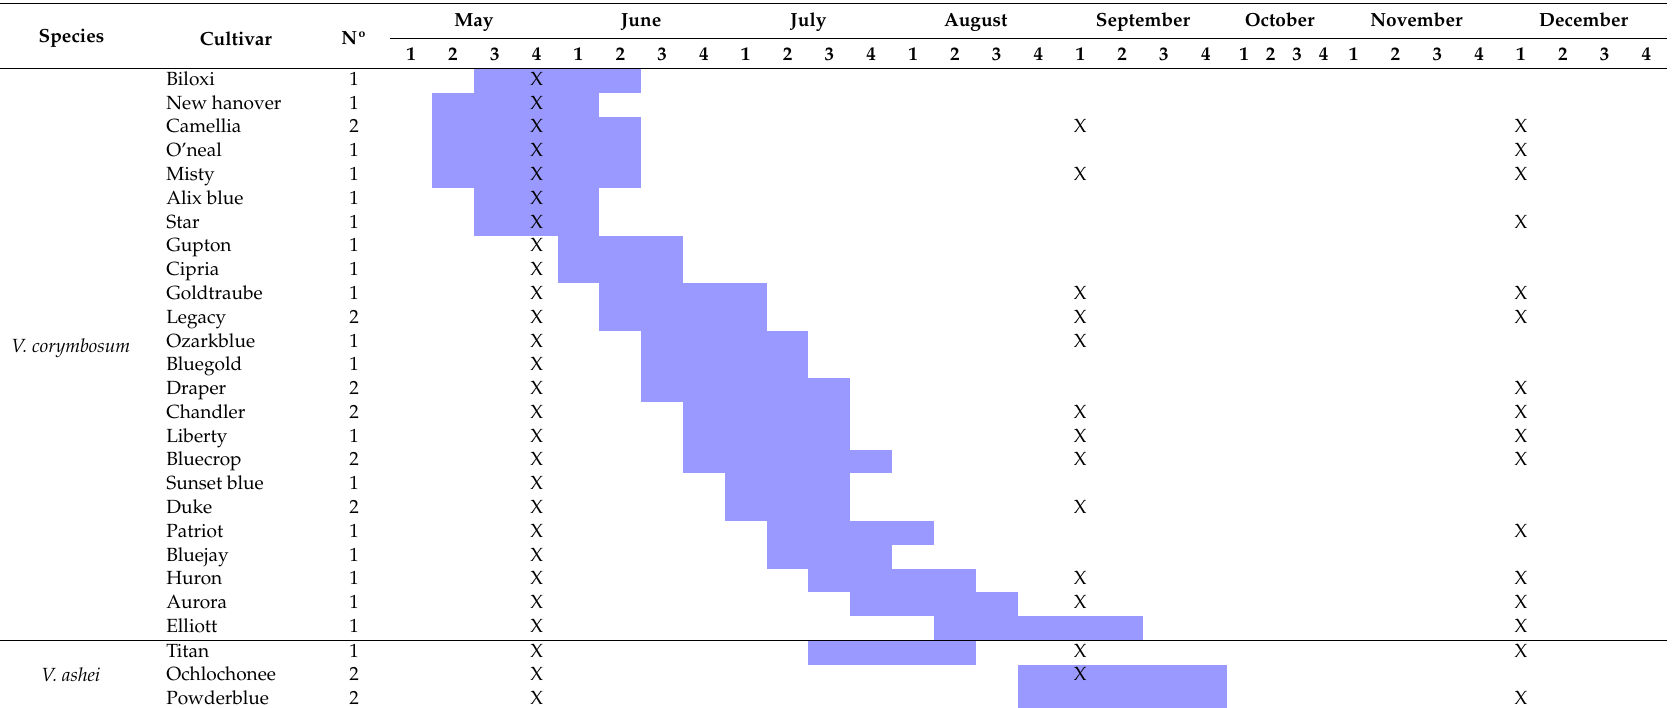
Table 5. Vaccinium spp. cultivar leaves included in this